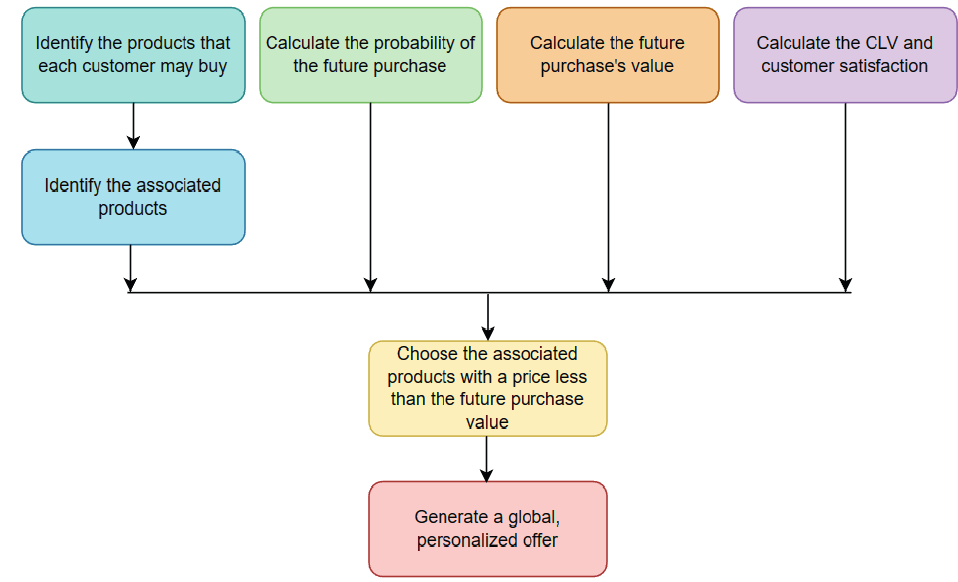
Fig. 1. Process of the offer generation